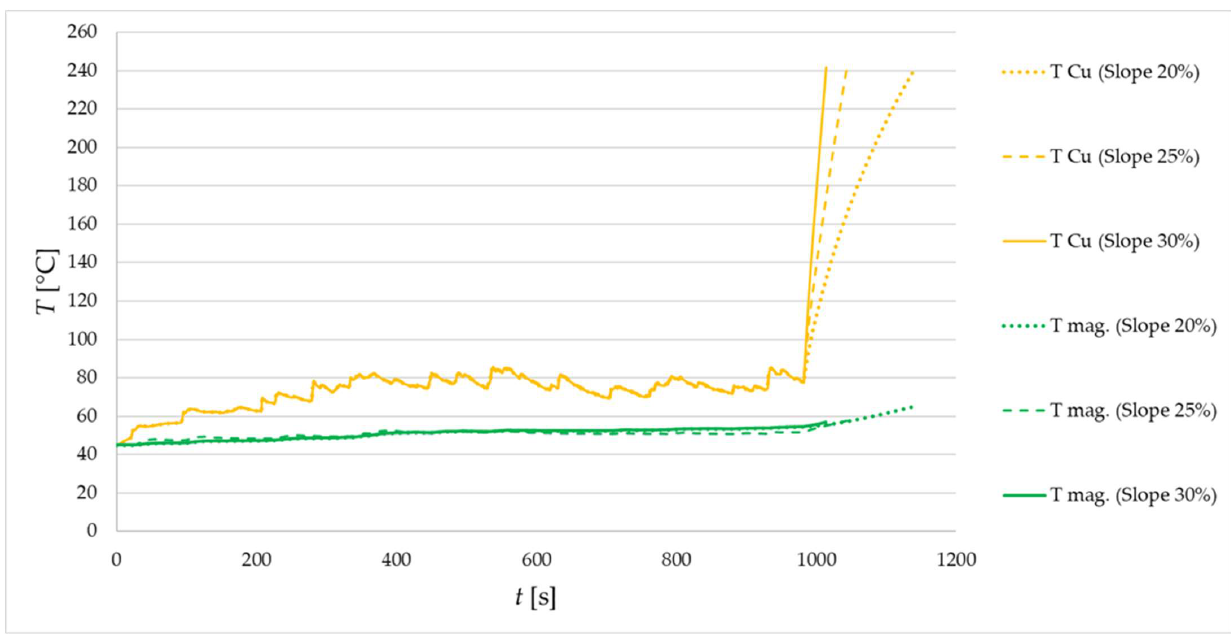
Figure 45. Calculated temperature waveforms of the winding and magnets while driving the car at a speed of v = 30 km/h, on the road with different slopes.